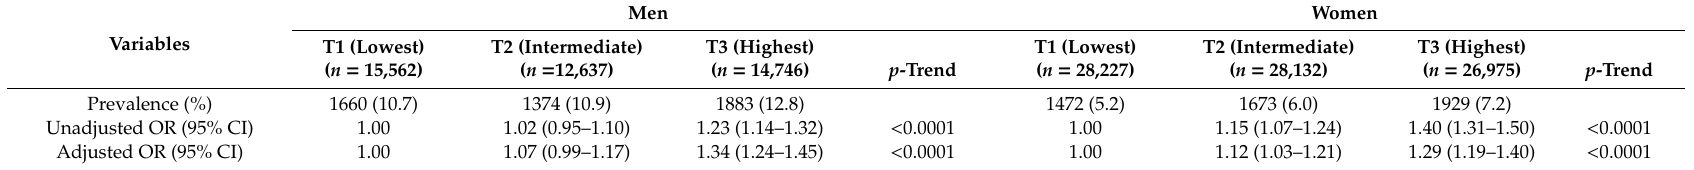
Table 2. Odds ratios (95% confidence intervals) for diabetes by tertiles of stress